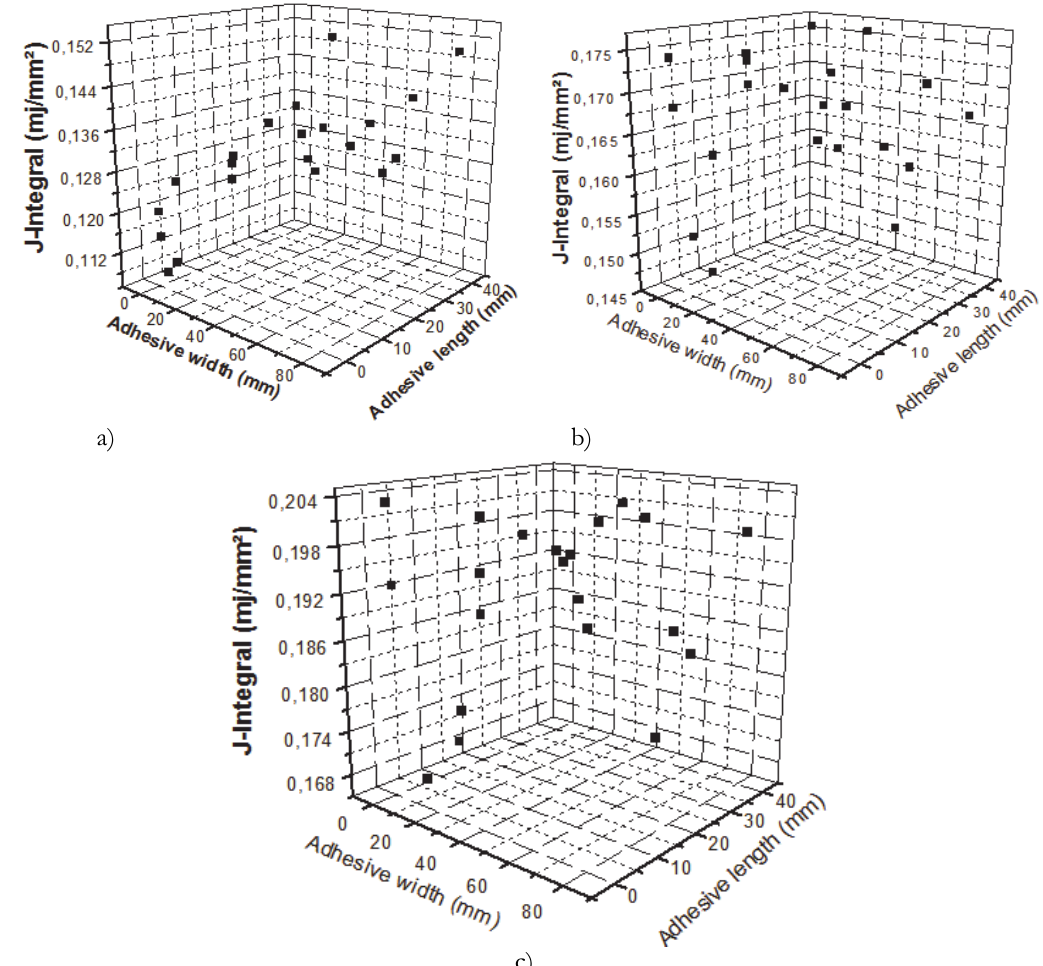
Figure 9 : Variation of the J-Integral in function of the position of the default has a) Crack length =10mm, b) Crack length =20mm, c) Crack length